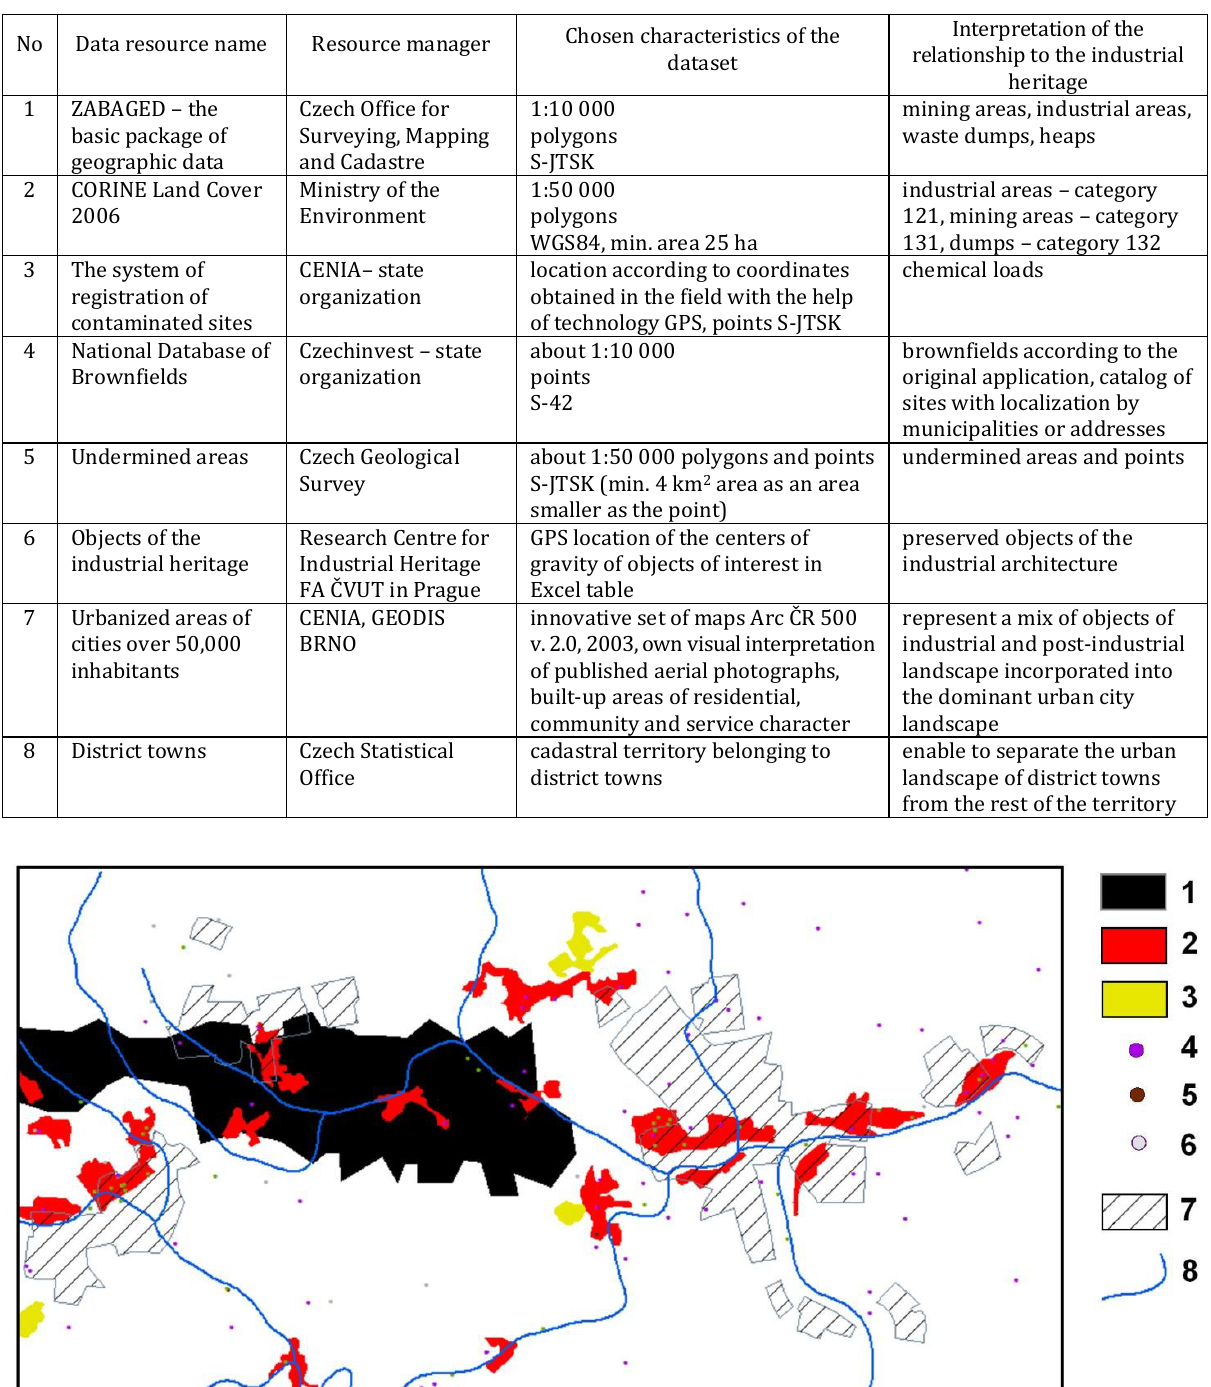
Table 1. Data sources used for identifying, mapping and classification of post-industrial landscapes in the Czech Republic